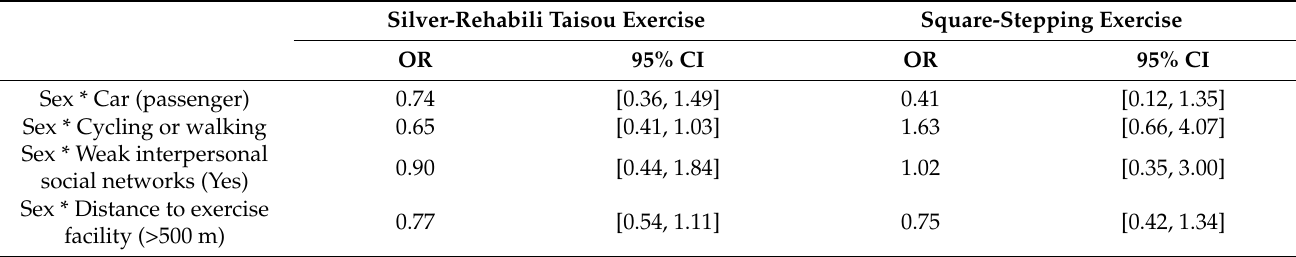
Table 4. Interactions between sex, interpersonal social networks, and distance to exercise facility, for